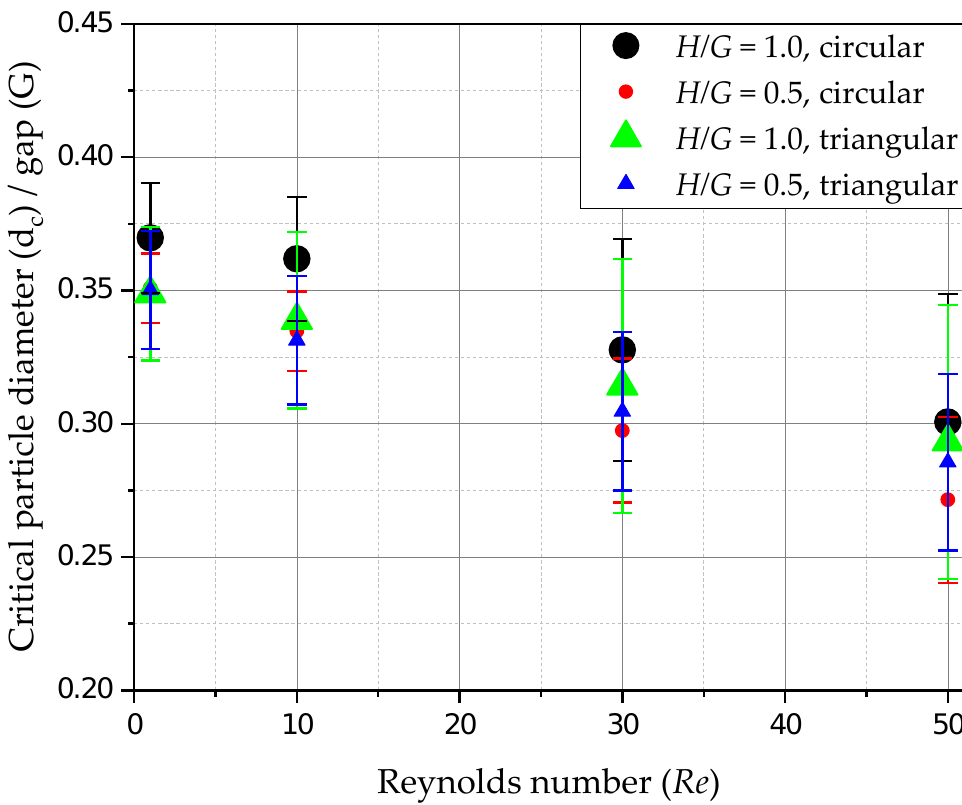
Figure 5. In this graph, the mean critical particle diameters, d c , normalized over the gap are plotted with standard deviation over the Reynolds number. These values are determined by the calculation of the first streamline widths.